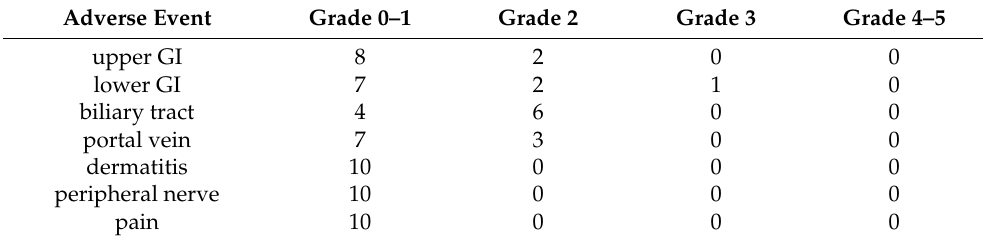
Table 3. Numbers of cases for each non-hematological adverse event after 2nd CIRT.